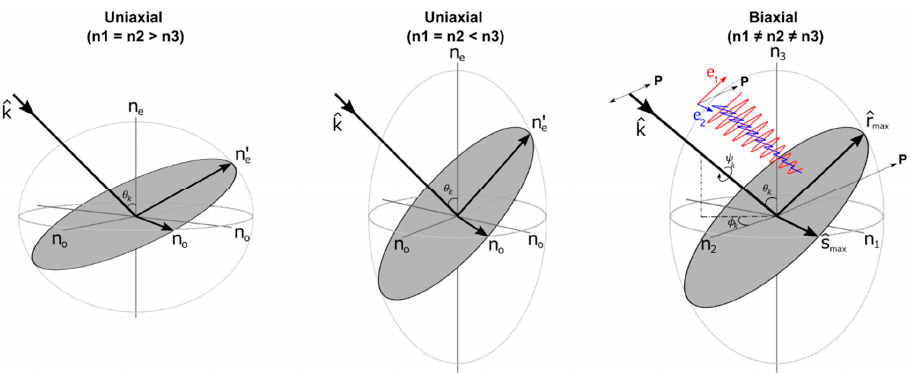
Figure 1. Negative uniaxial ( left ), positive uniaxial ( middle ), and biaxial ( right ) indicatrix represen- tations. The plane that is normal to the input k-vector bisects the indicatrix to create an ellipse, the semi-major axis of which are the decomposed electric field vectors. Due to symmetry one of the axes in the uniaxial case is always the same ( n o ). In the biaxial case the polarisation of the incident ray (P) is shown to decompose into e 1 and e 2 along the axis as defined by the semi-axis of the ellipse (ˆ s max & ˆ r max